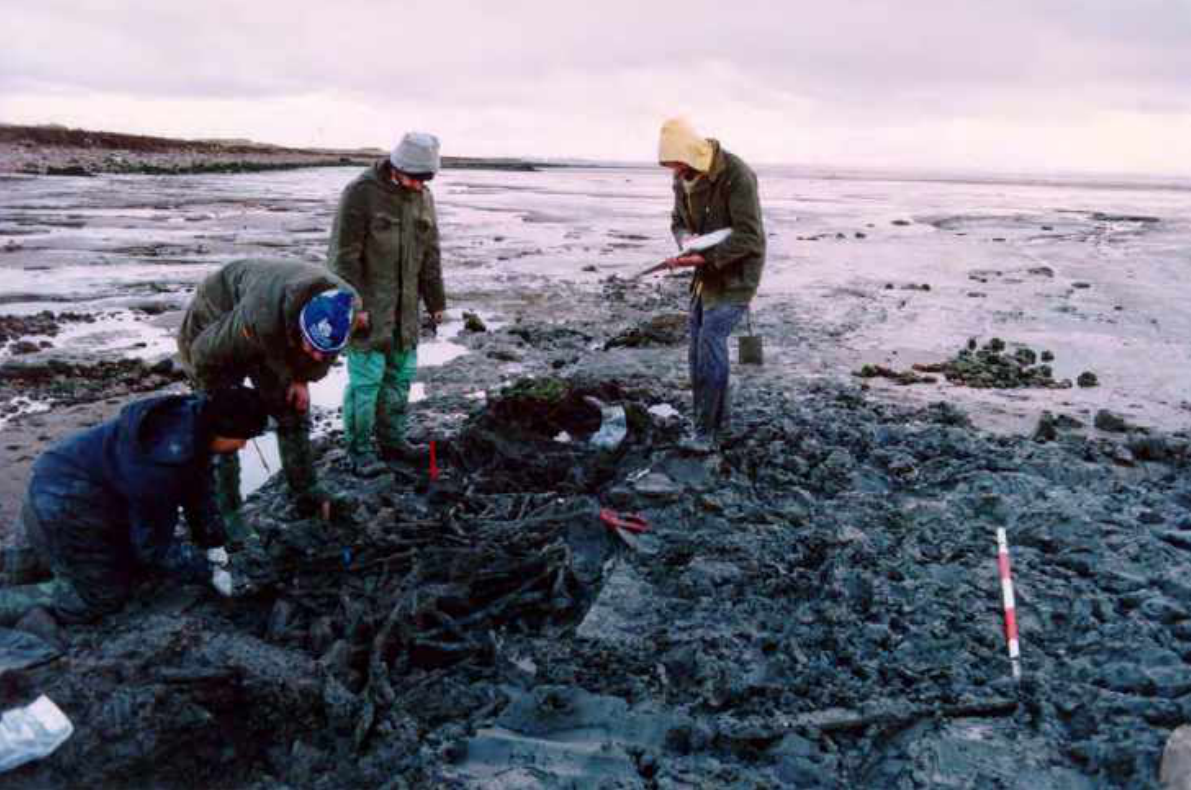
Fig 2.11 Excavation of a Neolithic timber structure at Hightown beach, Merseyside (Ron Cowell/National Museums Liverpool).